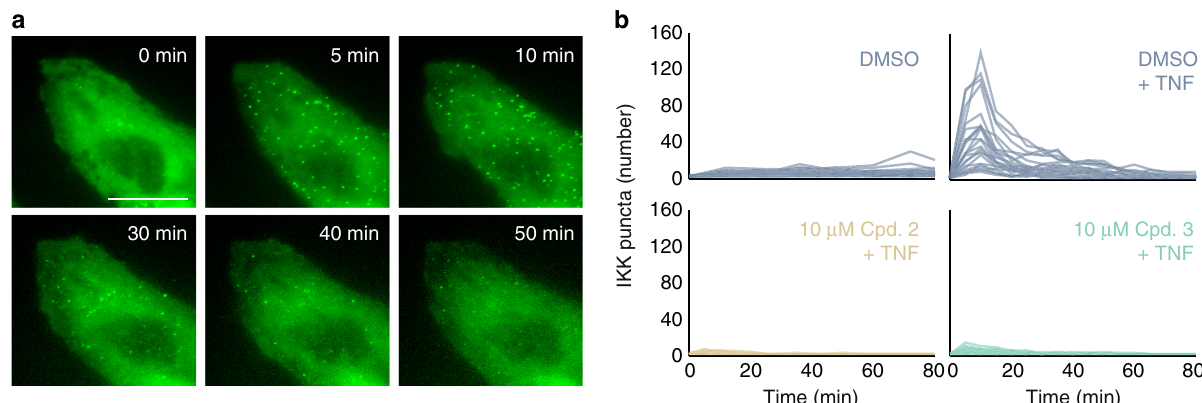
Fig. 5 Compounds limit the formation of IKK γ puncta in TNF-stimulated cells. a Time-lapse images of fl uorescent protein (FP)-IKK expressed from its endogenous gene locus in U2OS cells exposed to TNF. Scale bar is 20 µ m for all. See also Supplementary Movie 2; b Single-cell time courses for the number of FP-IKK puncta in cells stimulated with the indicated TNF conditions for cells pre-exposed to either dimethyl sulfoxide (blue lines), compound 2 (tan lines), or compound 3 (teal lines). In all TNF conditions, a concentration of 100 ng/mL was used. Source data are provided as a Source Data